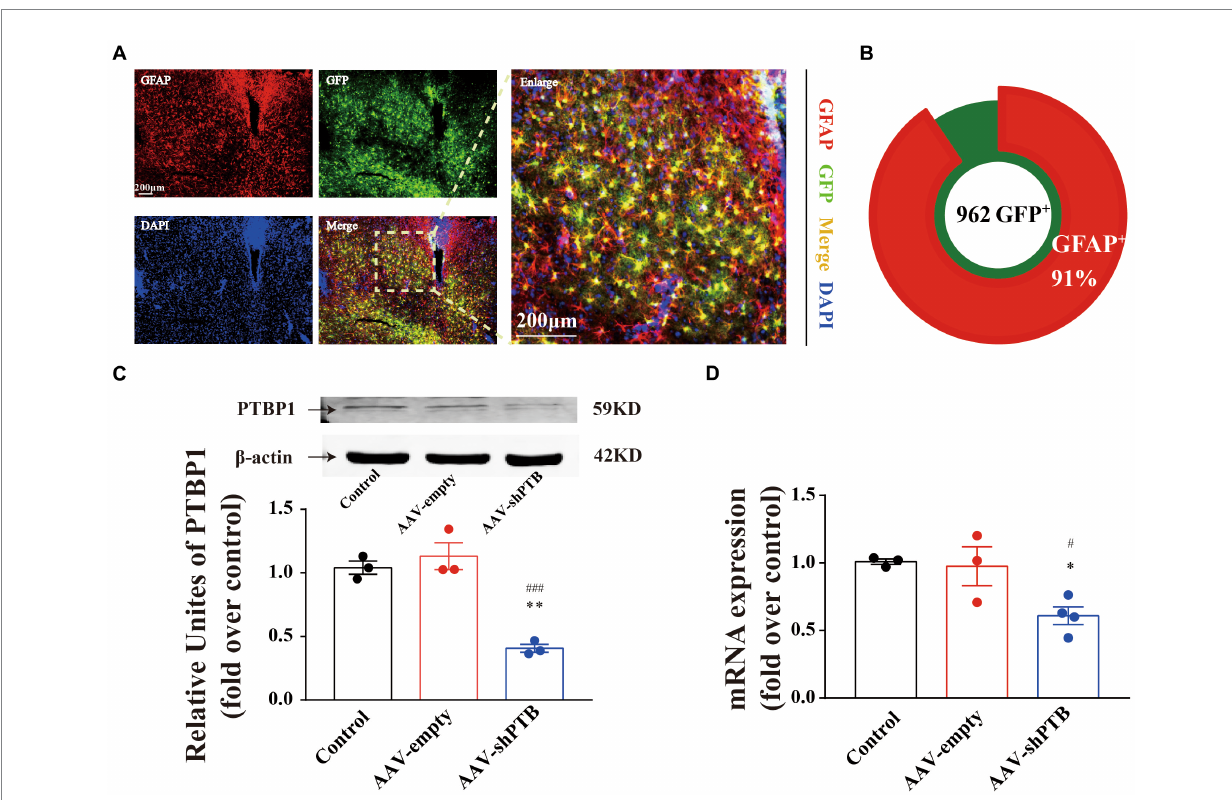
FIGURE 5 Adeno-associated virus-shRNA knock down PTB by degrading PTB mRNA. (A) Co-labeling of astrocyte promoter virus and GFAP protein. The images in right are an enlarged image. Scale bar represents 200 μ m. (B) The co-labeling rate of AAV with GFAP promoter and astrocytes was 91%. (C,D) The protein (one-way ANOVA, Tukey’s multiple comparisons test, F (2,6) = 31.56, ** p = 0.0017, ### p = 0.0008, n = 3) and mRNA (one-way ANOVA, Tukey’s multiple comparisons test, F (2,7) = 6.959, * p = 0.0317, # p = 0.0460, n = 3 in sham and AAV-empty group, n = 4 in AAV-shPTB group) contents of PTB in mice were significantly decreased by injecting AAV-shPTB. The arrow refers to the target band. *Means compared to sham group, # means compared to AAV-empty. The data are expressed as mean ±